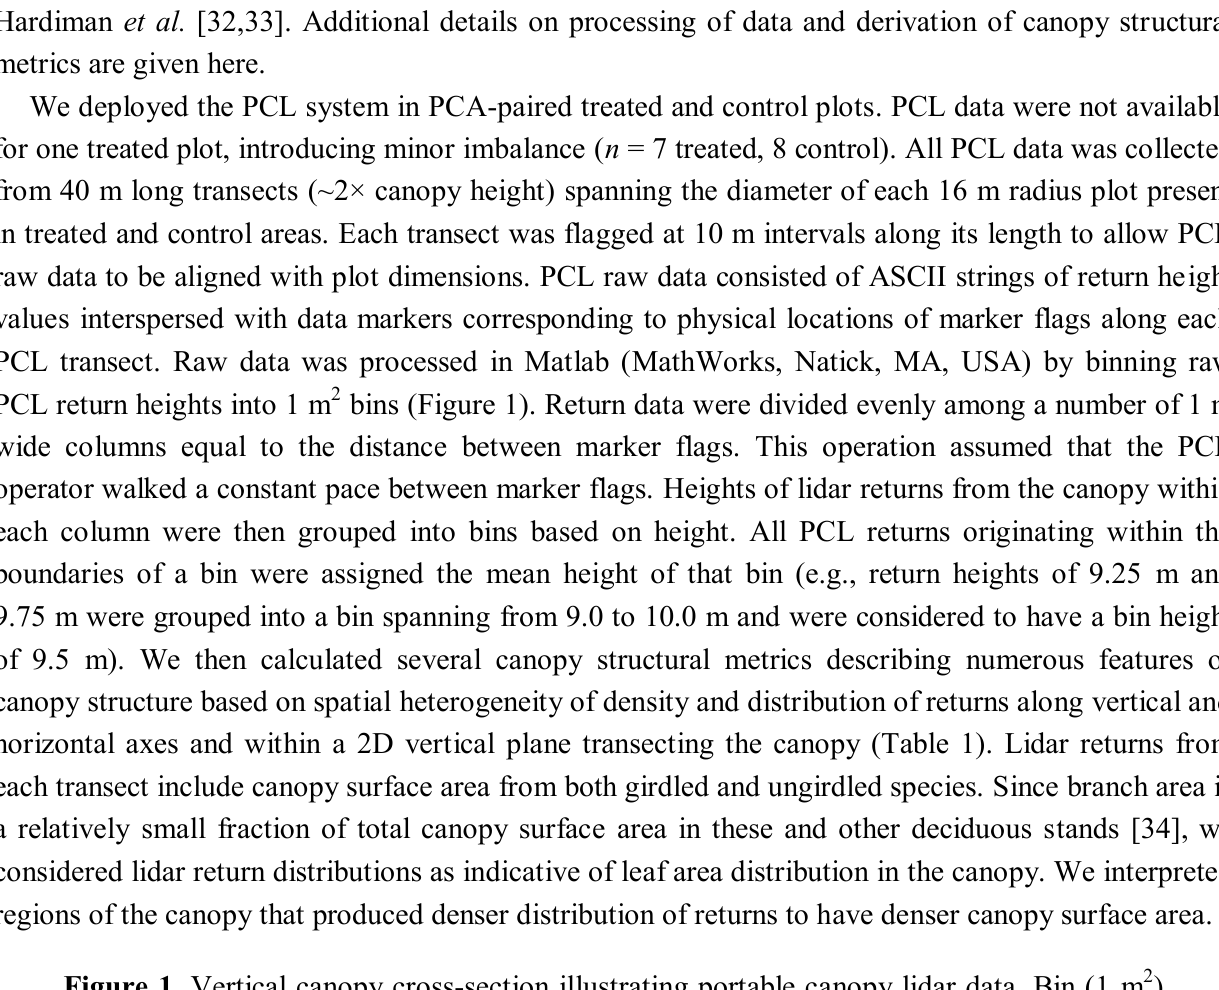
Figure 1. Vertical canopy cross-section illustrating portable canopy lidar data. Bin (1 m 2 ) shading is proportional to number of lidar returns. Canopy structural metrics were calculated from rows and columns of